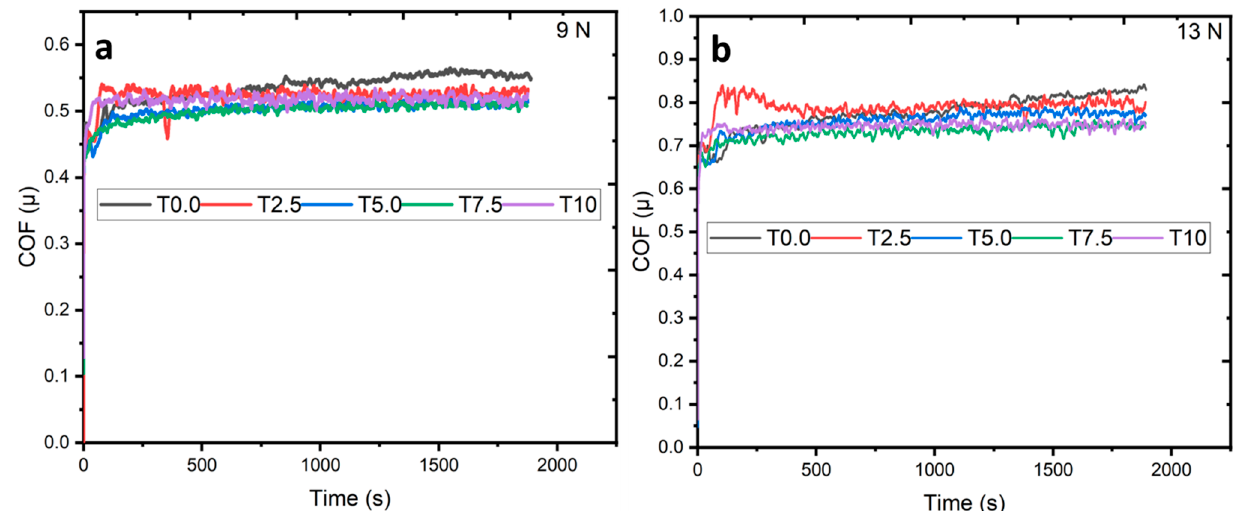
Figure 11. The variation of COF against time of the sintered samples under the applied load ( a ) 9 N and ( b ) 13 N.